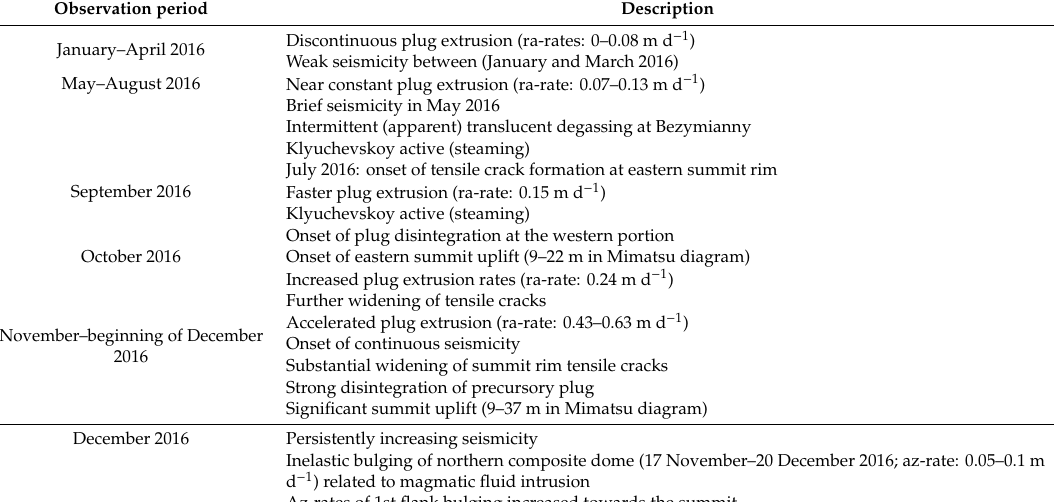
Table 1. Chronology of volcanic processes at Bezymianny between January 2016 and August 2018. The ra- and az-rates correspond to range and azimuth o ff set rates, respectively. FOV = field of view. Observation